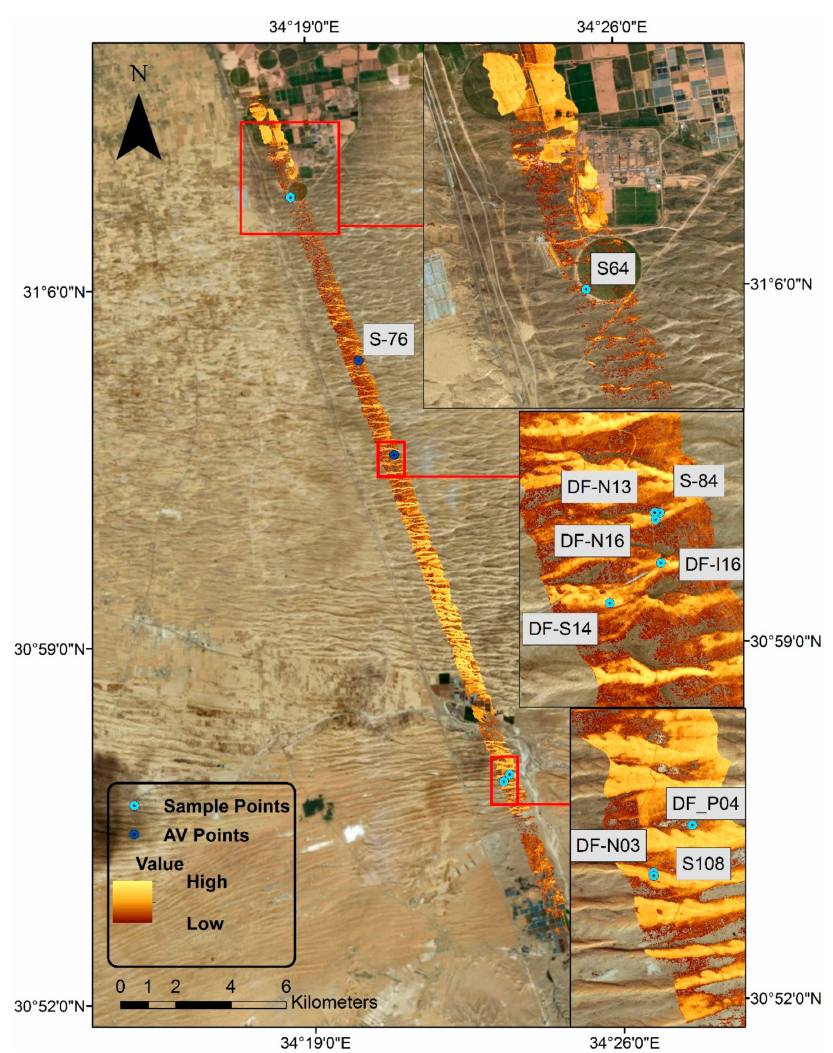
Figure 8. Relative amounts of quartz along the study area calculated from the AisaOWL image overlaid on a true color image. The 10 field sample points are marked in cyan. The two points used for validation of the atmospheric feature reduction procedure are marked in dark blue (AV). Background